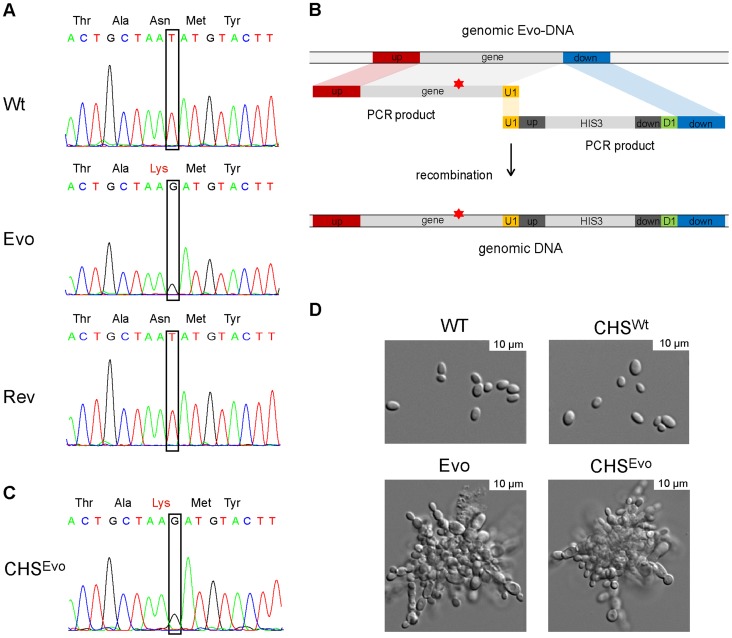
A single nucleotide exchange is sufficient to produce the evolved phenotype.A. Sanger sequencing confirmed the sequence alteration in CHS2 of the Evo strain (identified by whole genome sequencing), which led to an Asn→Lys (WT→Evo) amino acid exchange in the protein. Following a counter-selection experiment, the gene reverted to its original sequence (Rev), concomitant with the reversal to the original yeast growth form. B. This single nucleotide exchange observed in of the Evo strain was introduced into the WT strain by PCR amplification of CHS2 from the Evo strain, and cotransformation of this fragment with an PCR-amplified HIS3 marker including an overlapping (U1) region. C. The resulting strain was called CHSEvo, and correct integration was tested by sequencing. Similarly, CHSWT was created by amplifying the WT CHS2 gene and following the same cloning strategy. D. Morphologies of the WT, Evo, CHSWT and CHSEvo strain. The introduction of the Evo CHS2 gene into CHSEvo resulted in a growth form indistinguishable from the original Evo strain. The reintroduction of the WT gene did not change morphology (CHSWT).